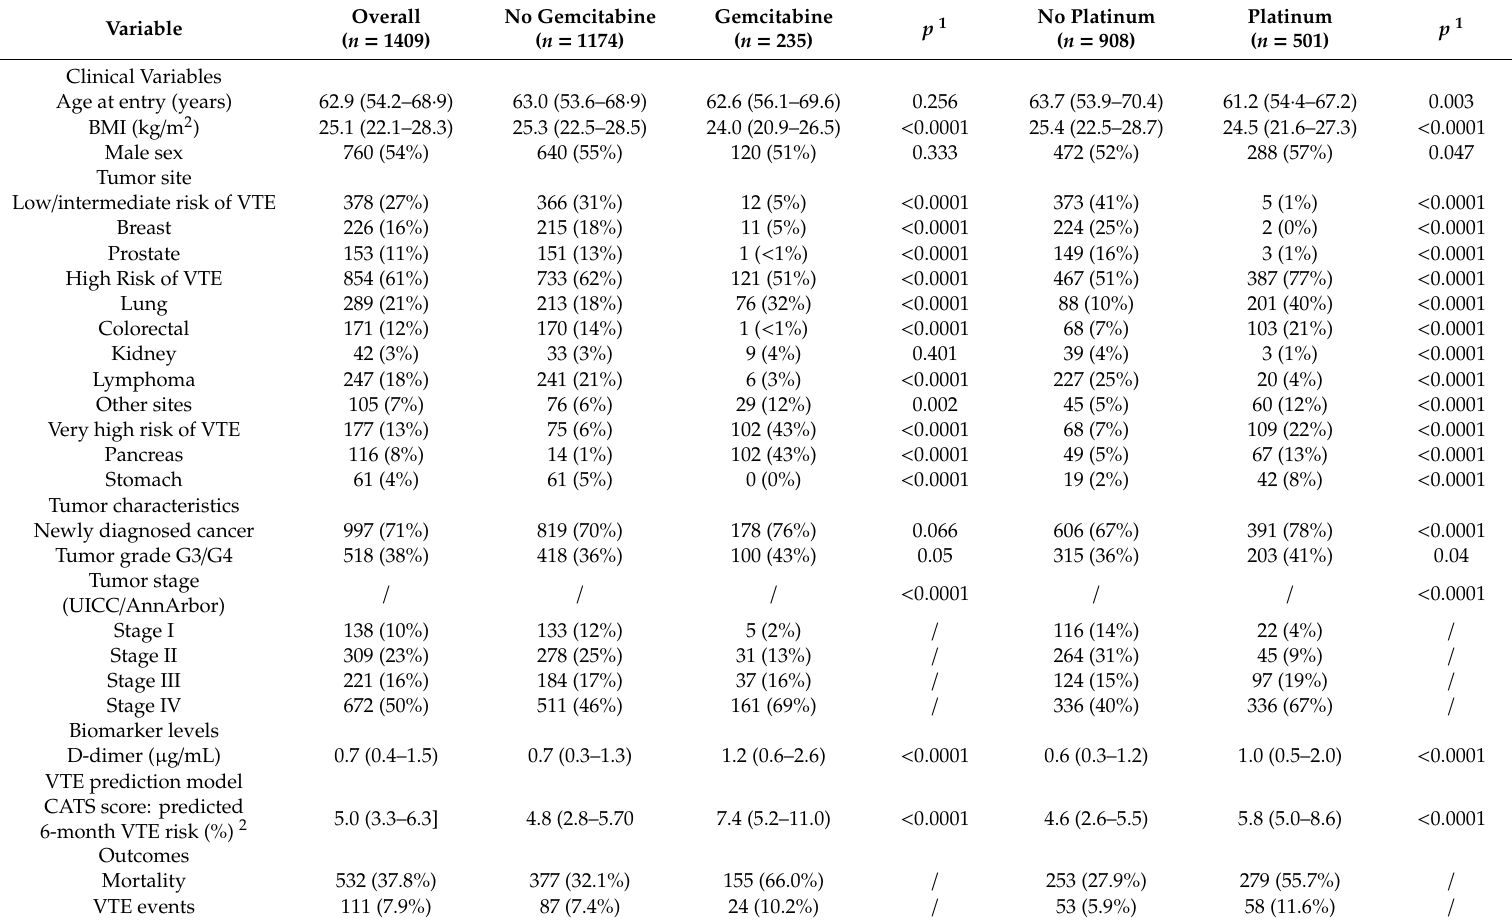
Table 1. Baseline characteristics of study